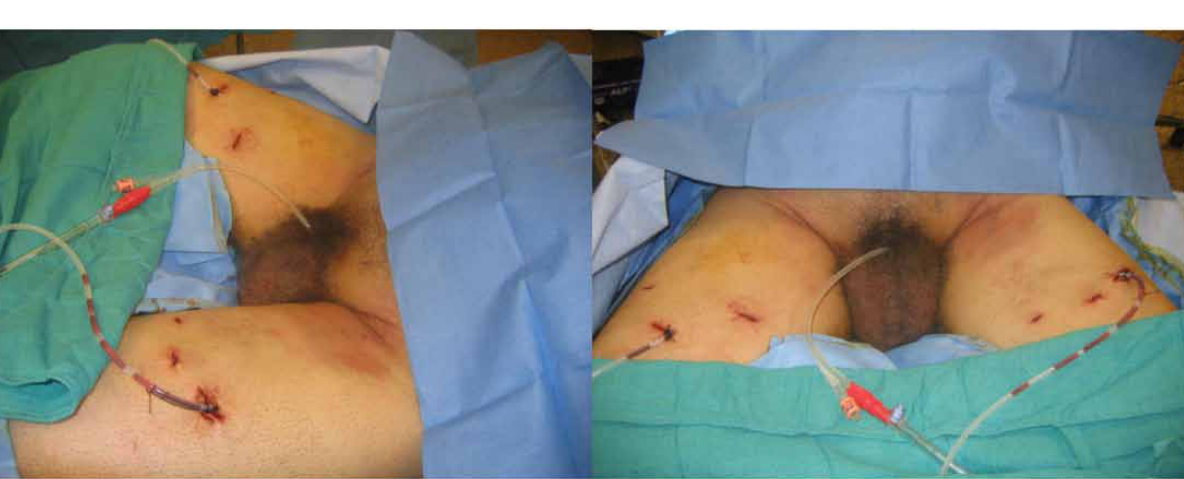
Figure 2 - Final aspect of the trocar incisions and